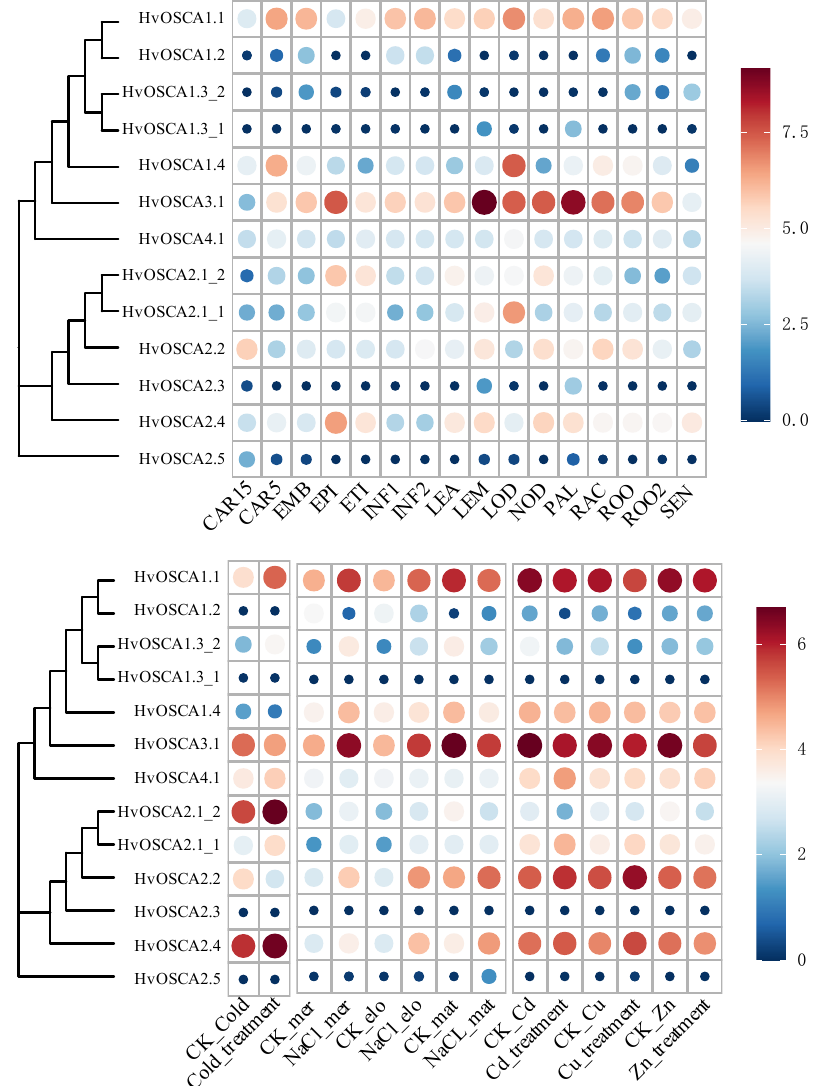
Figure 4. Expression profiles of HvOSCAs in different tissues and under diverse stresses. ( A ) The spatio-temporal expression profile of HvOSCAs in different tissues at different developmental stages. FPKM values were normalized by log 2 (FPKM+1) transformation to display the heatmap color scores. CAR15: bracts removed grains at 15DAP; CAR5: bracts removed grains at 5DAP (CAR5); embryos dissected from 4-day-old germinating grains (EMB); epidermis at 4 weeks old (EPI); etiolated from 10-day-old seedling (ETI); young inflorescences with 5 mm (INF1); young inflorescences with 1–1.5 cm (INF2); shoot with the size of 10 cm from the seedlings (LEA); lemma at 6 weeks after anthesis (LEM); lodicule at 6 weeks after anthesis (LOD); developing tillers at the six-leaf stage (PAL); 6-week-old palea (NOD); rachis at 5 weeks after anthesis (RAC); root from 4-week-old seedlings (ROO2); roots from the seedlings at the 10 cm shoot stage (ROO). ( B ) Expression profile of HvOSCAs under cold, NaCl and heavy metal ion (Cd, Cu and Zn) conditions. Cold stress treatment: CK of cold (CK_cold), cold (4 ◦ C) treatment (Cold_treatment), salt treatment of barley root (dissected and sampled the barley according to the organizational structure of root for meristem zone, elongation zone and mature zone). CK of meristem zone (CK_mer), meristem zone under salt treatment (NaCl_mer), CK of elongation zone (CK_elo), elongation zone under salt treatment (NaCl_elo), CK of maturation zone (CK_mat) and maturation zone under salt treatment (NaCl_mat). Heavy metal ion (Cd, Cu and Zn) stress. Control of cadmium ion stress (CK_Cd), cadmium ion treatment (Cd_treatment), control of copper ion treatment (CK_Cu), copper ion treatment (Cu_treatment), control of zinc ion stress (CK_Zn) and zipper ion treatment